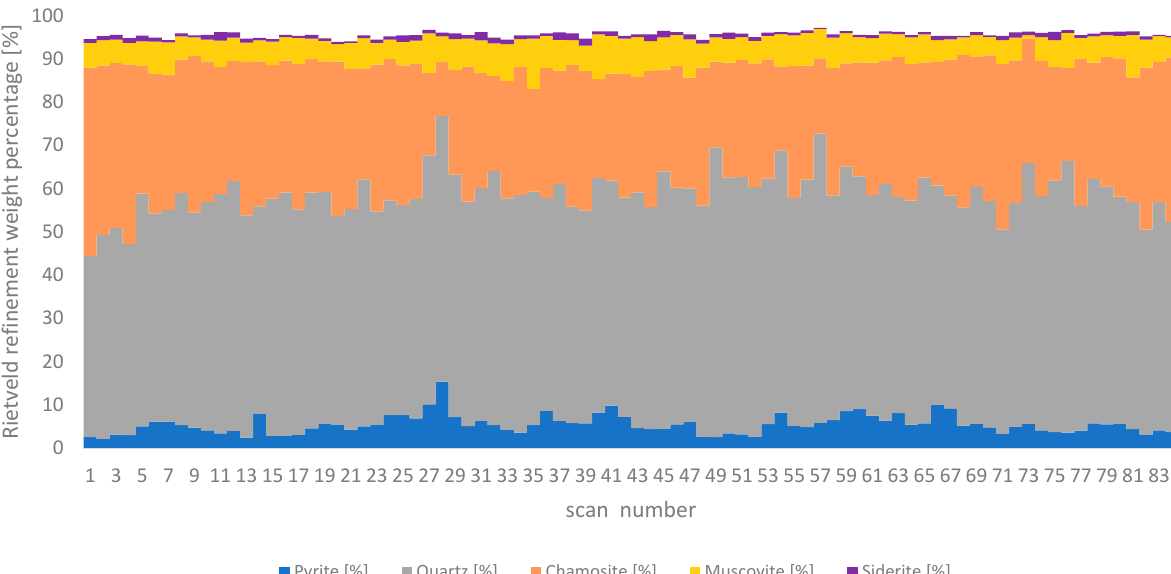
Figure 5. Mineralogical variability of ore blends for the major gangue minerals as determined by XRD and Rietveld re- finement.